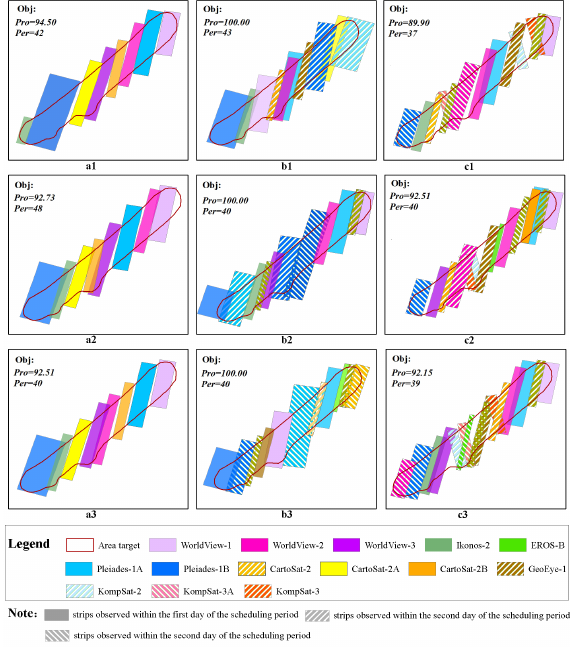
Figure 6. The scheduling schemes for Scenario